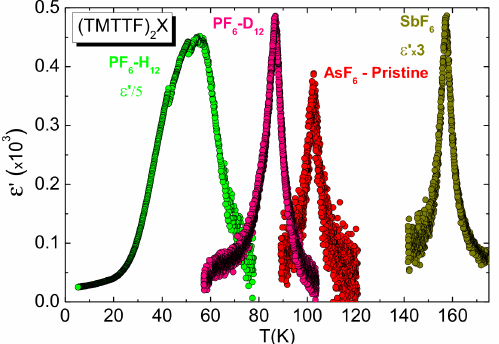
Figure 21. Temperature dependence of the dielectric constant of several (TMTTF) 2 X salts with octahedral anions: H 12 -(TMTTF) 2 PF 6 and D 12 -(TMTTF) 2 PF 6 , (TMTTF) 2 AsF 6 and (TMTTF) 2 SbF 6